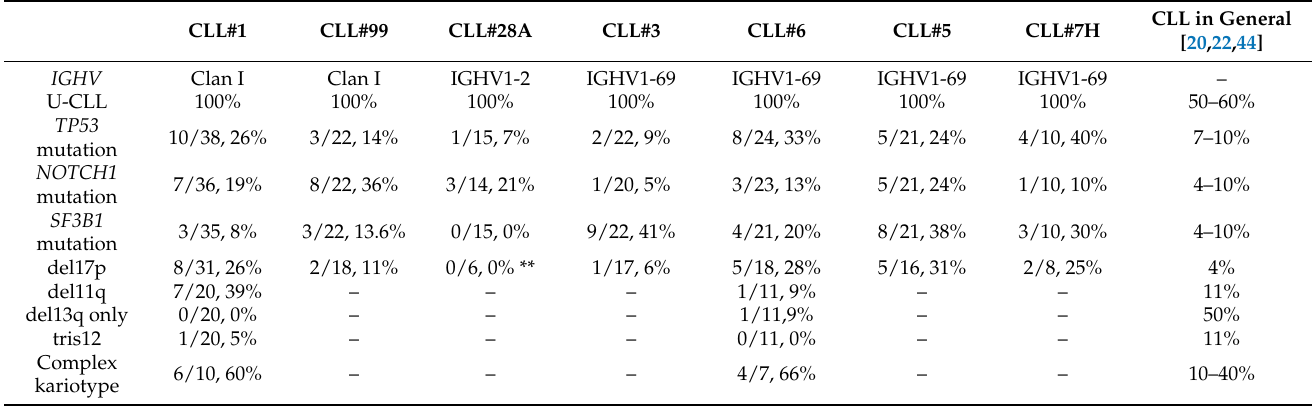
Table 2. The frequency of genetic lesions in most common SAR subgroups of Russian CLL patients. (** in the only patient with the TP53 mutation in this subgroup, the loss of a 17p locus fragment was subsequently detected using chromosomal micro-array analysis